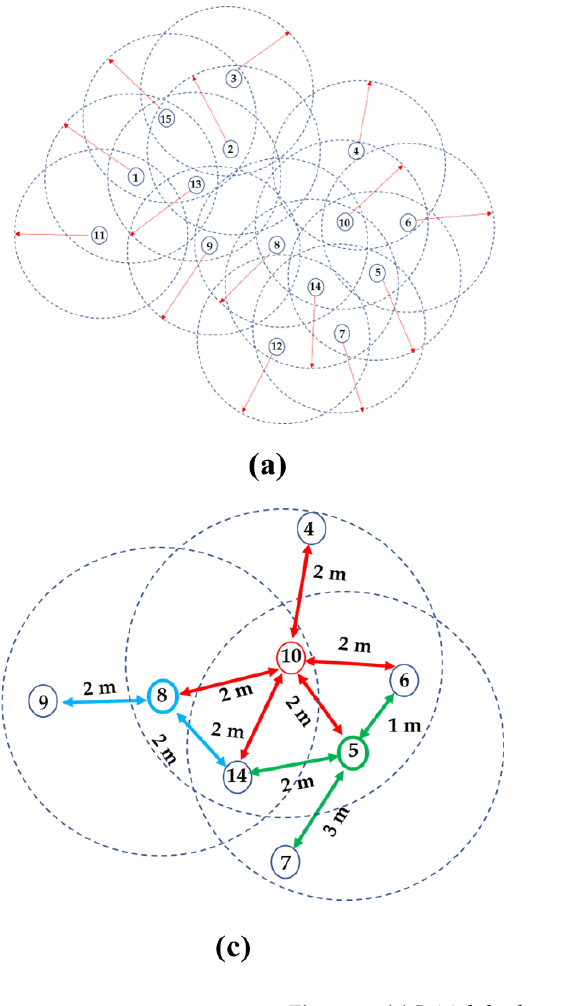
Figure 4. ( a ) Initial deployment of sensor nodes; ( b ) identification of neighbor nodes, ( c ) an example of the node-to-node distance calculation; ( d ) identification of the cluster head using the CWCA.